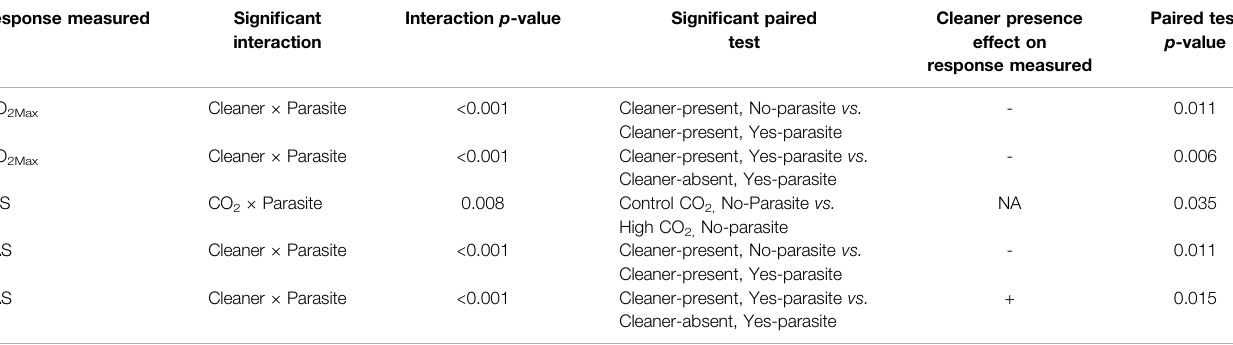
TABLE 1 | Summary of results of the post-hoc multiple comparisons in relation to the effect of cleaner fi sh treatment (presence or absence). Response